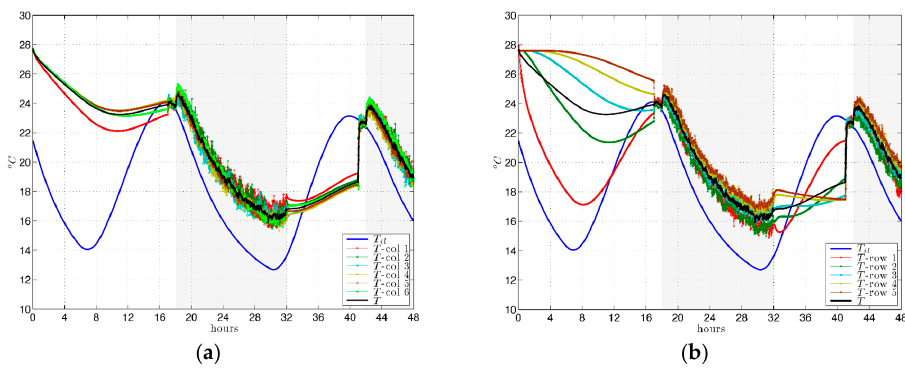
Figure 8. Case 1: Le Corbusier hypothesis. Summer. Internal layer temperature T il and averaged room temperature T together with calculated indoor temperatures at the probe points given in Figure 4. ( a ) by columns; ( b ) by rows.